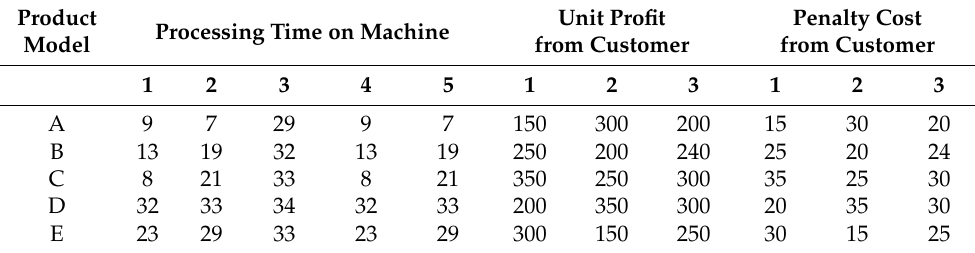
Table 3. Processing time of the product models on different machines. Product